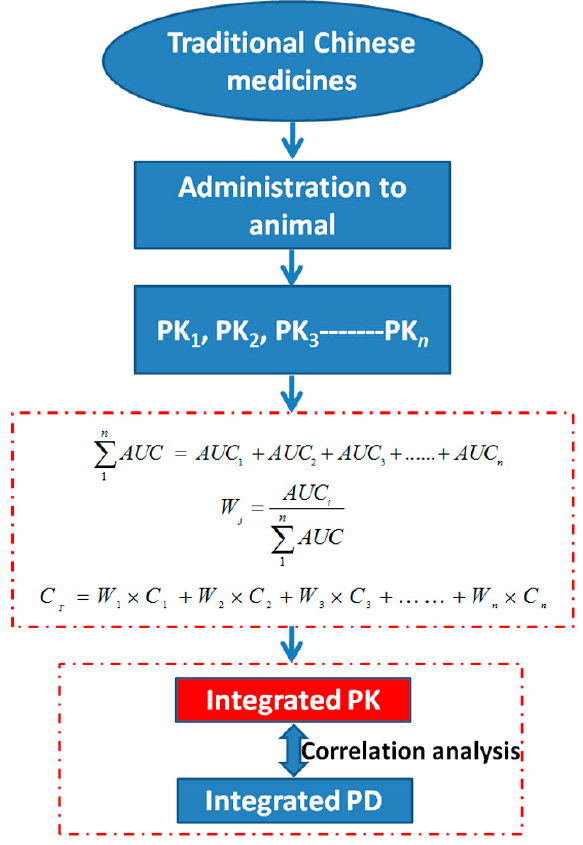
Figure 4. The integrated pharmacokinetics for TCMs.